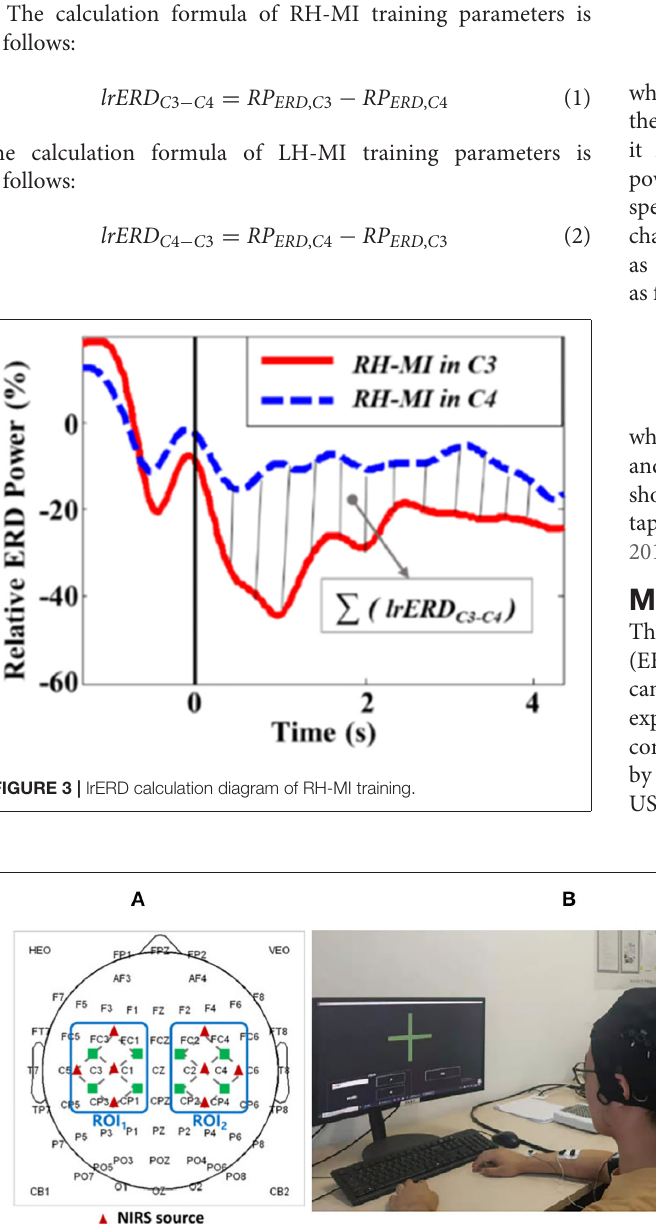
Frontiers in Neuroscience |